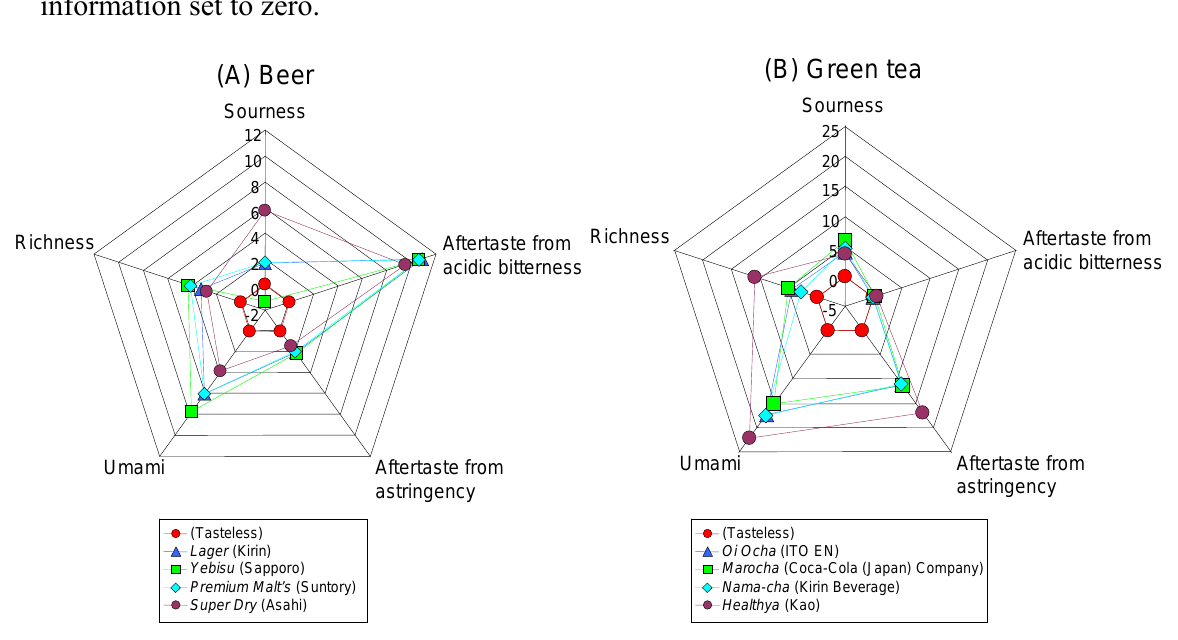
Figure 15. Radar charts for beer and green tea. In both radar charts, a reference solution of 30 mM KCl and 0.3 mM tartaric acid was used as a tasteless sample with taste information set to